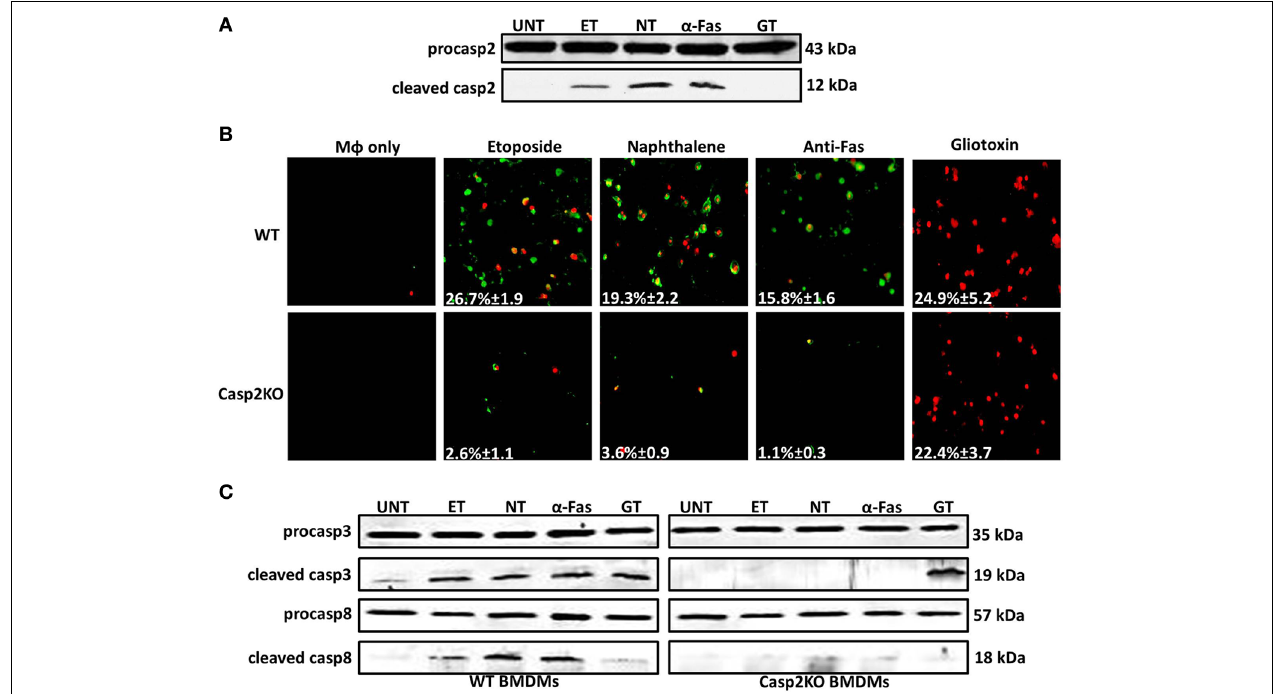
stained with Annexin V/propidium iodide (PI). Adherent cells were visualized by fluorescence microscopy (100x). Cells were counted in randomly selected fields of 100 cells. Images are representatives of n ≥ 3 independent experiments. (C) Caspase-3 and − 8 cleavage (activation) in ET, NT, α -Fas, GT treated WT and casp2 − / − BMDMs. Immunoblots are representatives of n ≥ 3 independent